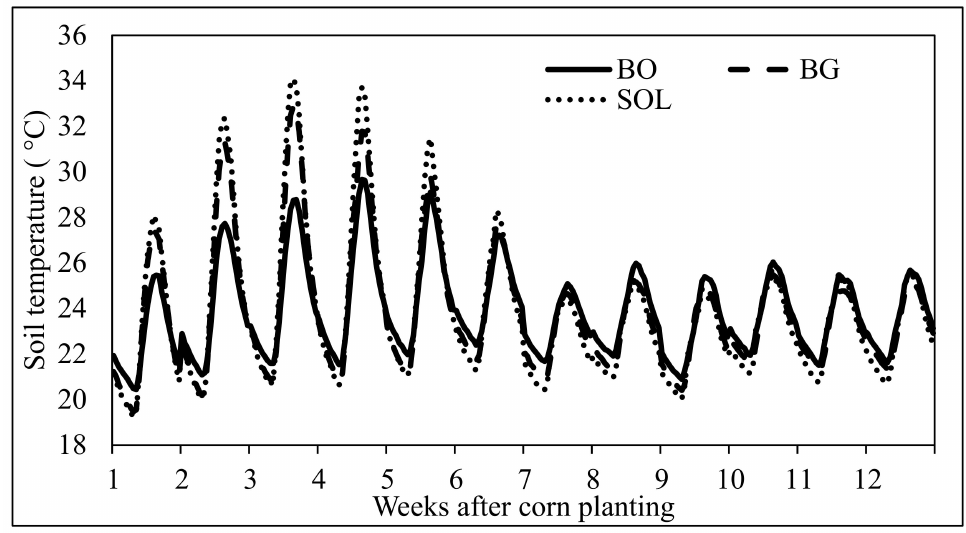
Figure 2. Means of 7-day soil temperatures recorded hourly throughout the 3 months of the corn growing period in trial II. BG = bare ground conventional tillage; BO = no-till with black oat cover crop; SOL =